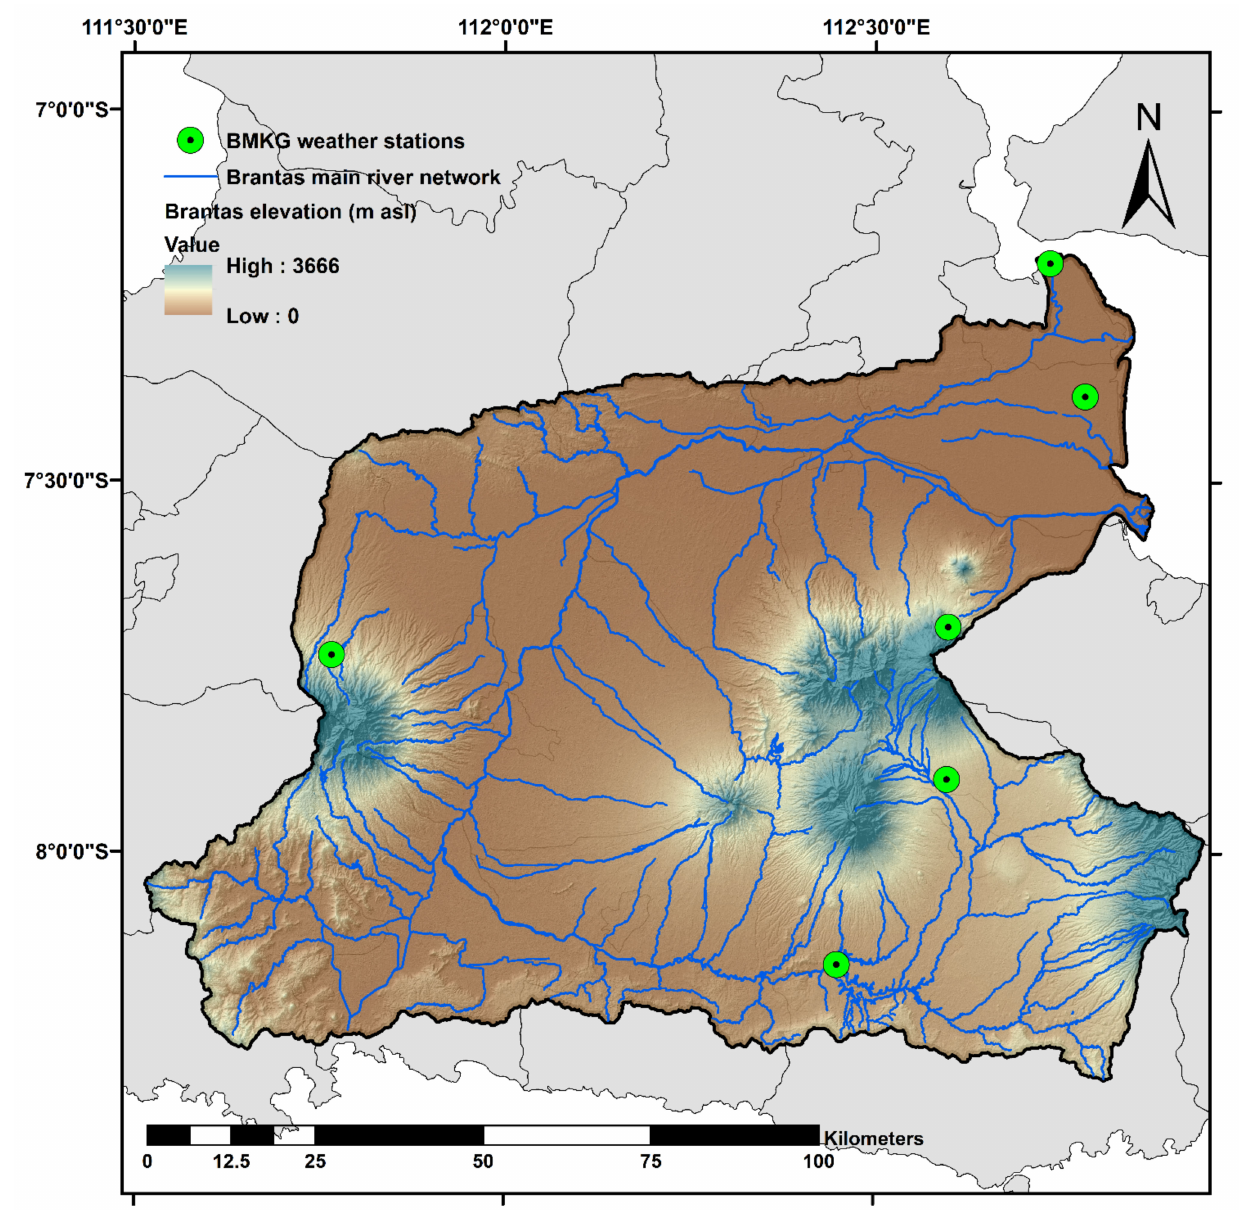
Figure 1. Study area of the Brantas watershed and distribution of validation locations (green